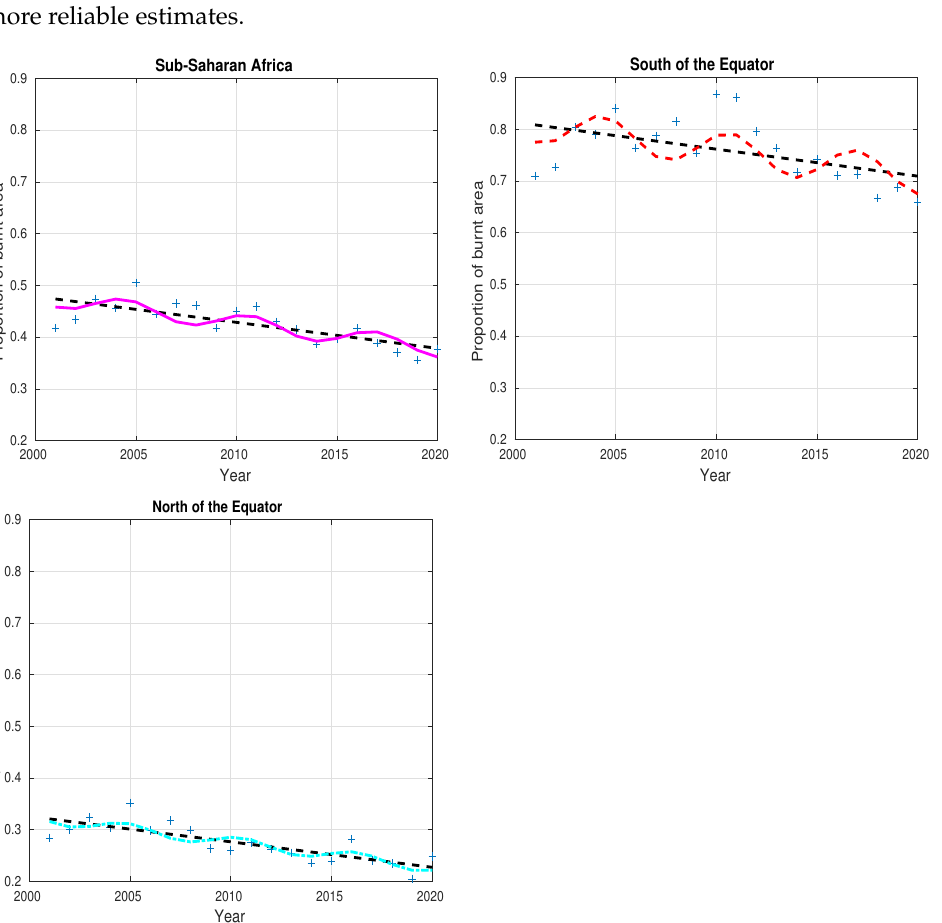
Figure 5. Graphs showing the trends of aggregated fires over all sub-Saharan Africa, southern- hemisphere Africa, and northern sub-Saharan Africa. Plus signs are the actual observation points, dot- ted lines are the linear regression fits, and the solid line is the fitted oscillatory line using nonlinear least